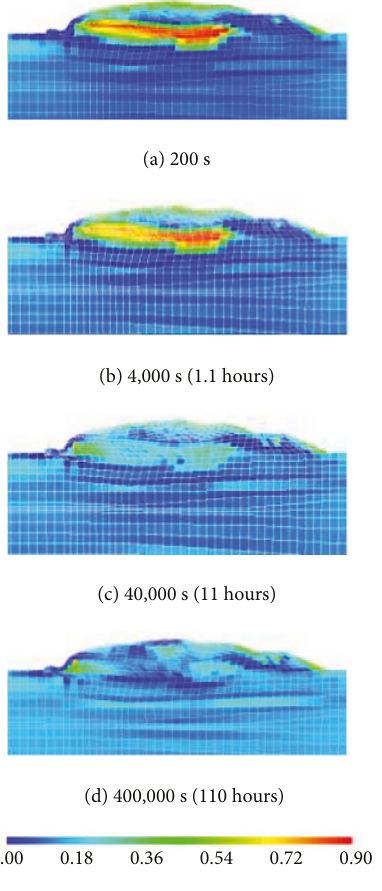
Figure 34: Distribution of mean skeleton stress decreasing ratio (ESDR) during reconsolidation.